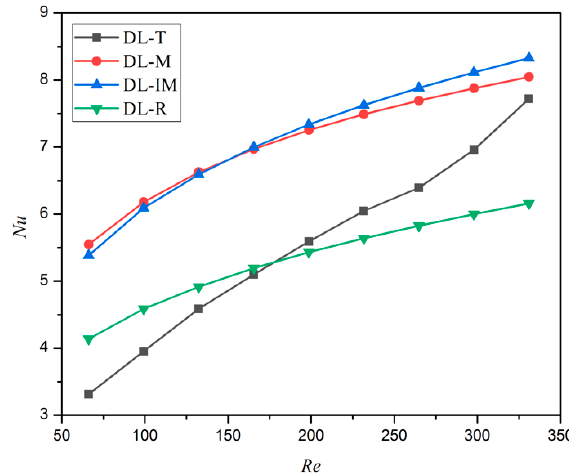
Figure 17. The variation of the Nusselt number vs. the Reynolds number.